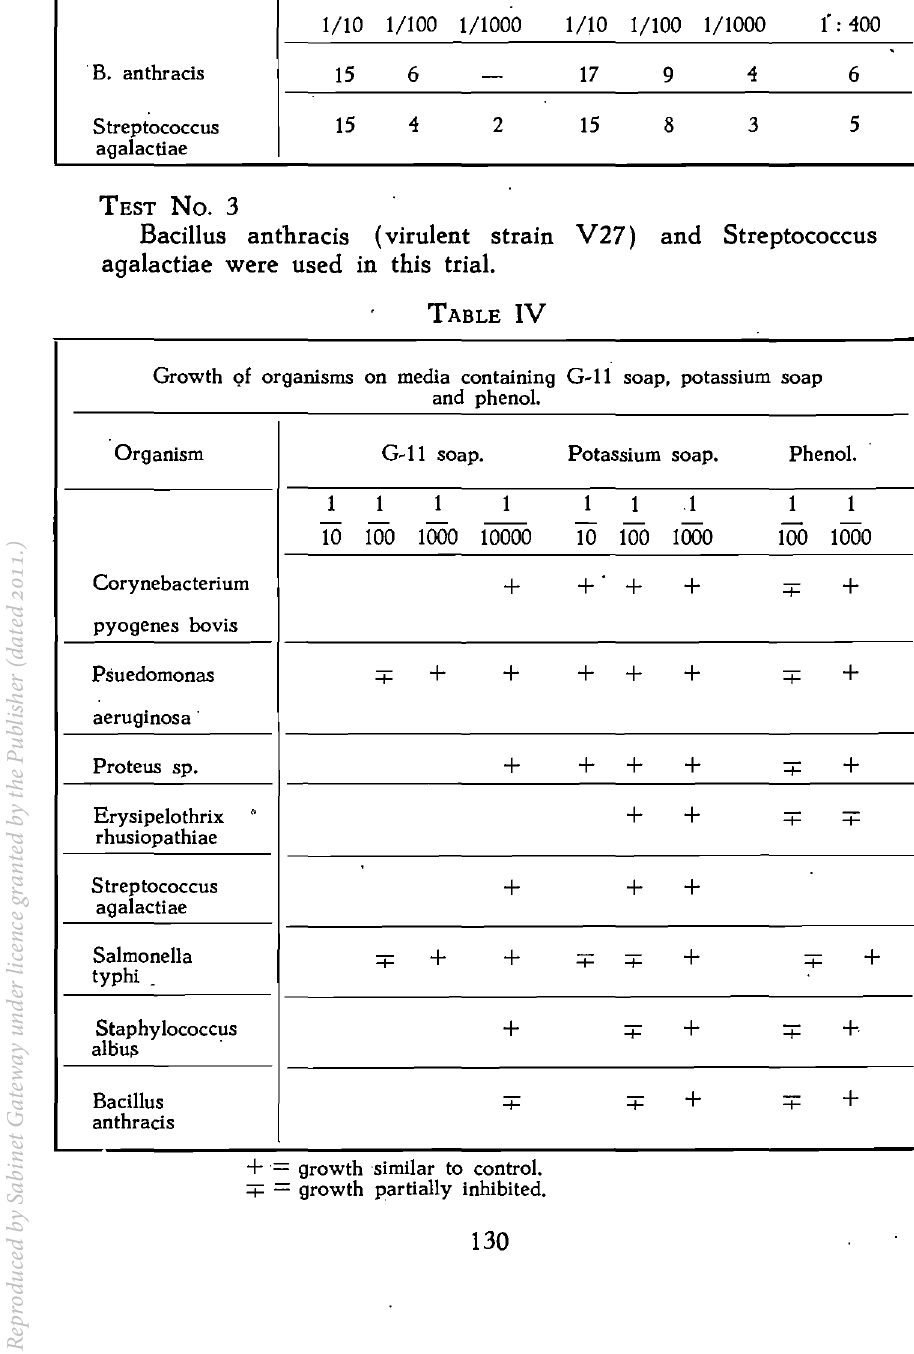
Diameter of Zone of Inhibition in Millimetres.